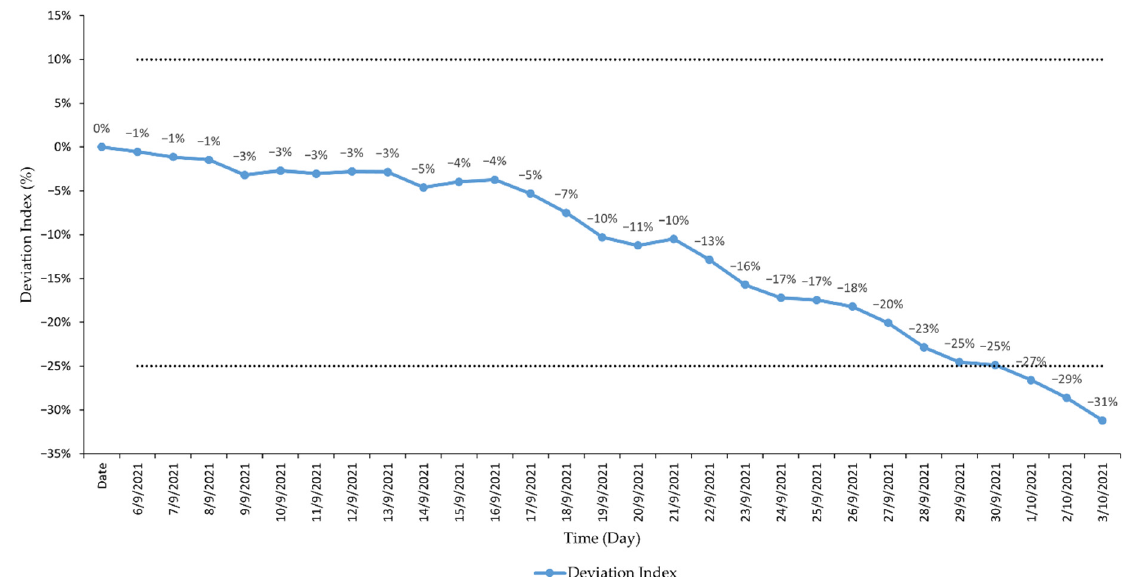
Figure 4. SARIMA (1,2,1) (2,0,0) model forecasted and the 7-day MA observed daily COVID-19 cases from 6 September 2021 to 3 October 2021, Malaysia (28-day forecast).